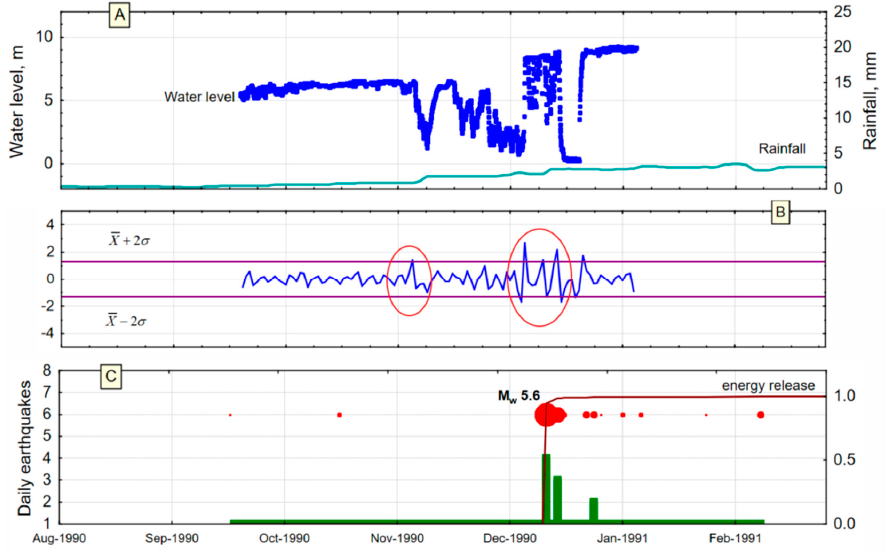
Figure 7. Tectonic-related anomalous signal of water level recorded in the E29 well. ( A ) Water level data recorded during the August 1990-February 1991 period; ( B ) irregular component of water level signal (processed with Census I method [32]). Anomalies are encircled by red ellipses; ( C ) seismic activity: green bars-number of daily earthquakes; red dots-seismic events with radius proportional to the magnitude; brown line-normalized cumulative curve of energy release calculated according to the relation log E = 1.5 × M L + 11.8 [33]. Seismic information from [69] and the Italian Seismological Instrumental and Parametric Database (ISIDe;